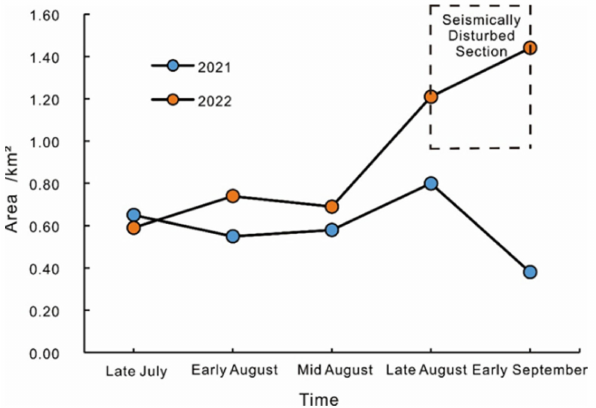
Figure 10. Area change of the significant deformation